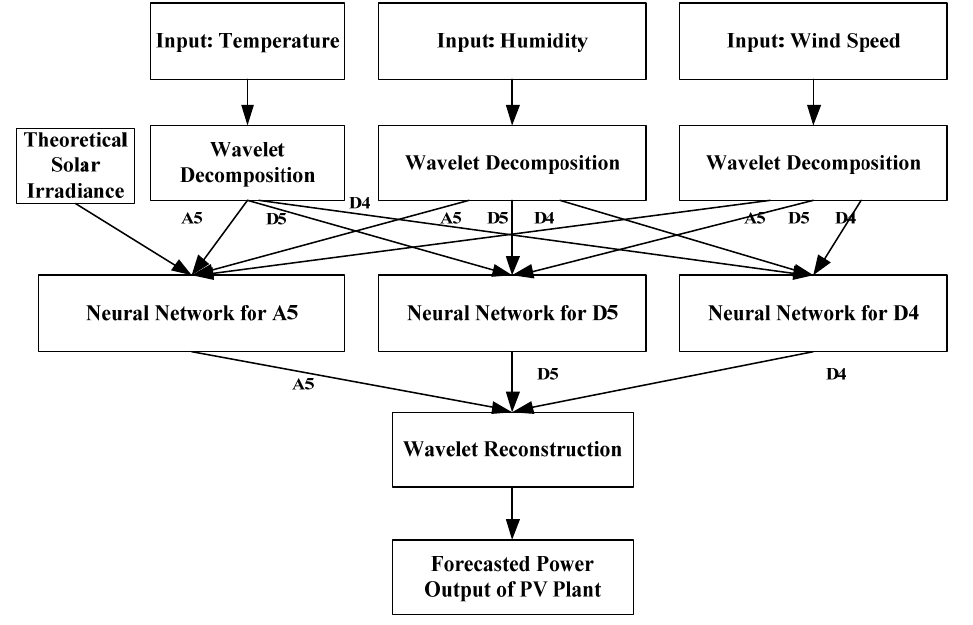
Figure 7. Frame diagram of algorithm.